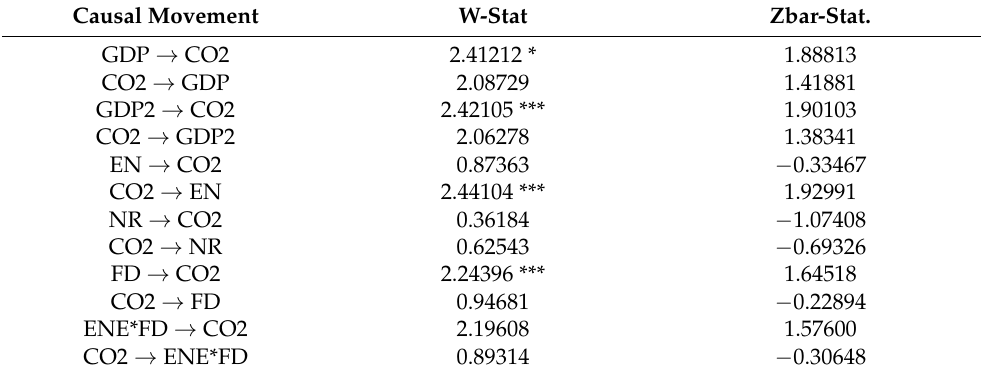
Table 7. Causality test.